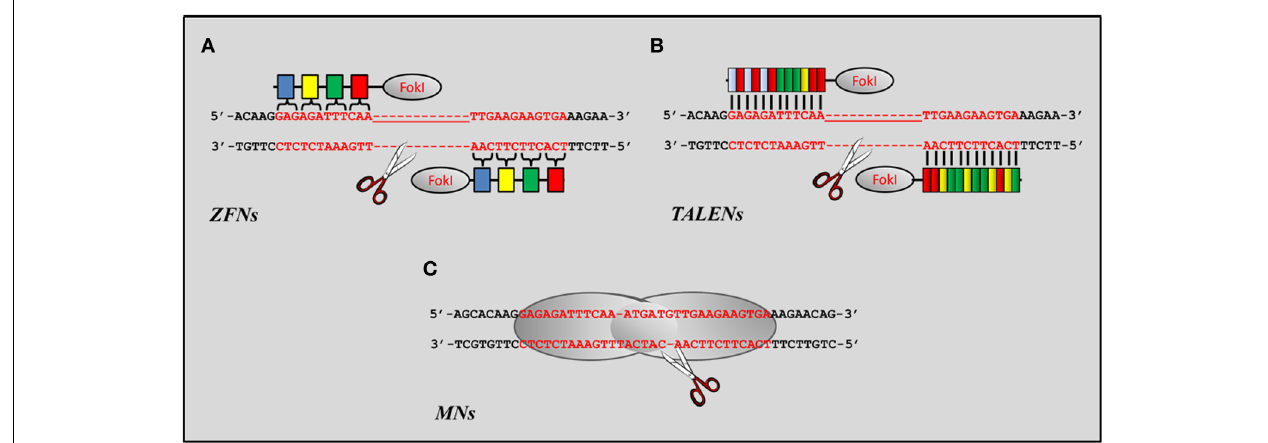
FIGURE 3 | Nucleases currently used as gene editing tools for muscle disorders. (A) Schematic representation of a ZFN dimer bound to its target. Each ZFN contains the cleavage domain of Fok I linked to a series of zinc fingers each designed to specifically recognize trinucleotide sequences (colored boxes) flanking the cleavage site. (B) Schematic representation of a TALEN dimer. Like ZFNs each TALEN contains the catalytic domain of the Fok I endonuclease flanked by modules responsible for the recognition of the